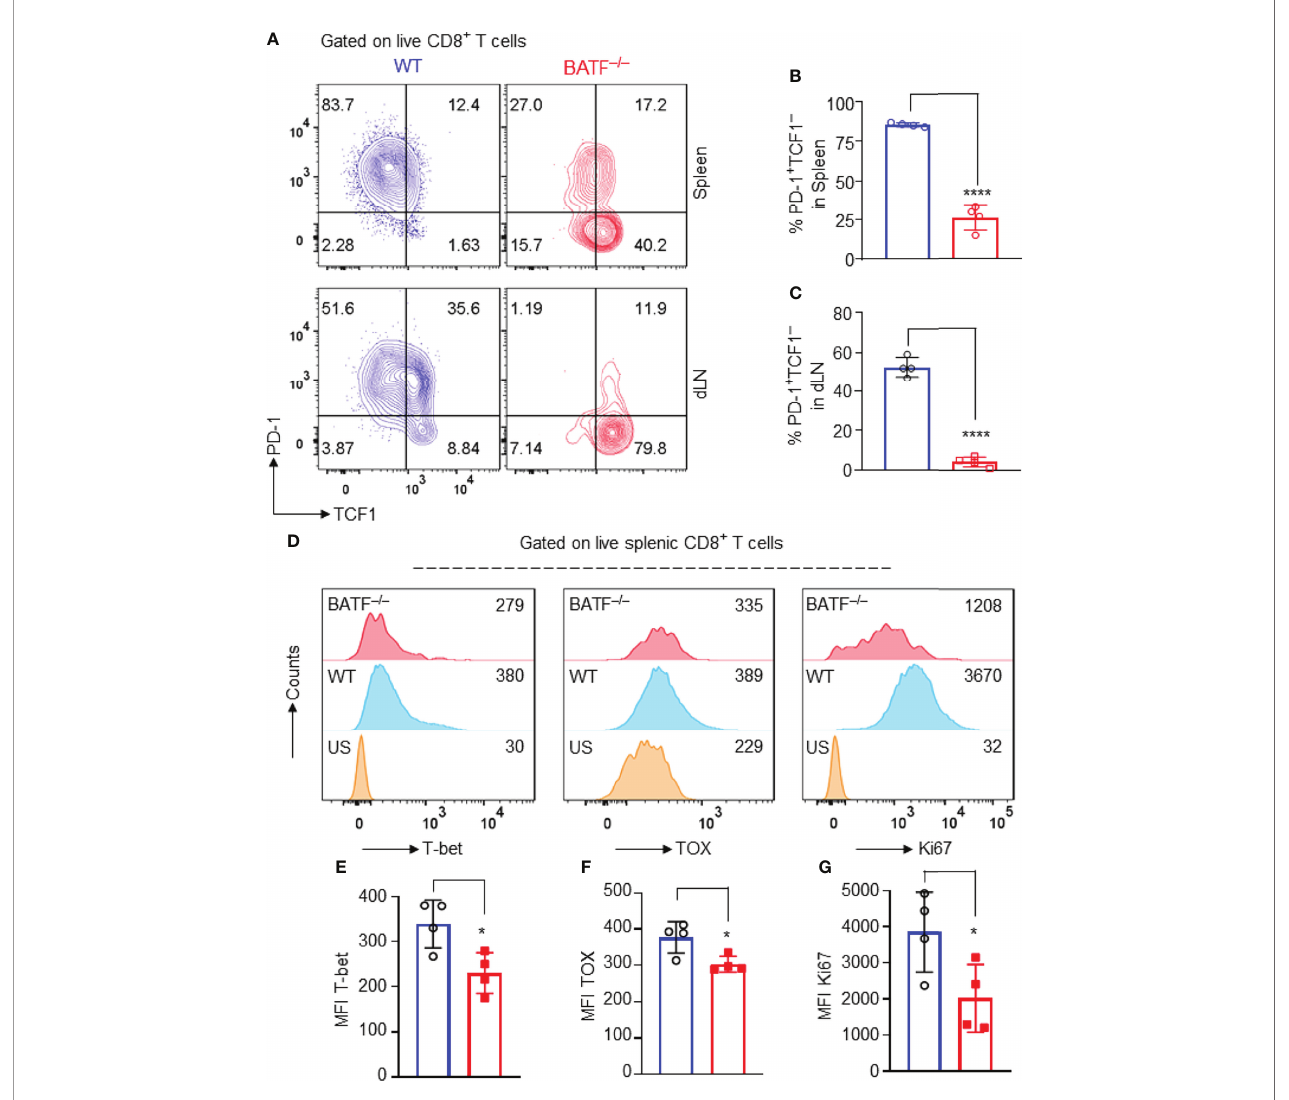
FIGURE 5 | BATF de fi ciency may perturb the transcriptional networks that control the effector programs of CD8 + T cells. B6. Rag1 – / – mice were reconstituted with a mixture of WT and BATF – / – CD8 + T cells, and were transplanted with Balb/c skins 1 day later. The expression levels of several transcription factors were determined on day 11 after skin transplantation. All plots were gated on live splenic CD8 + T cells. (A – C) Representative plots and bar graphs show the expression levels of TCF1 and PD-1 of the transferred WT and BATF – / – CD8 + T cells. (D – G) Representative histograms and bar graphs display the expression levels of T-bet, TOX and Ki67 in the transferred CD8 + T cells. Data represent the mean ± SD (n = 4). * p < 0.05, **** p < 0.0001; (unpaired Student ’ s t